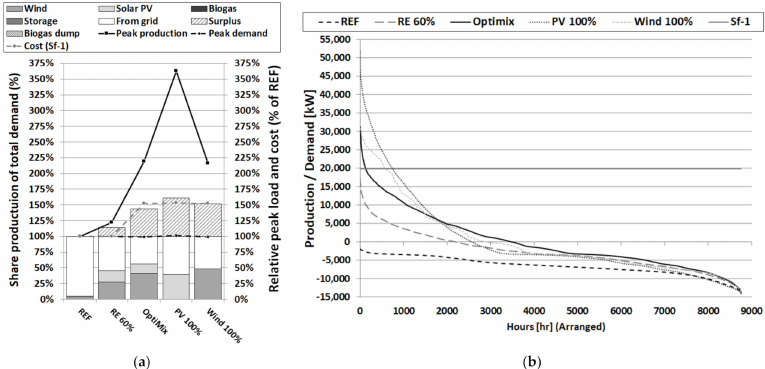
Figure 5. ( a ) Share of total demand per production I-RE Municipality Scenarios, ( b ) Net load duration curves of the I-RE Municipality